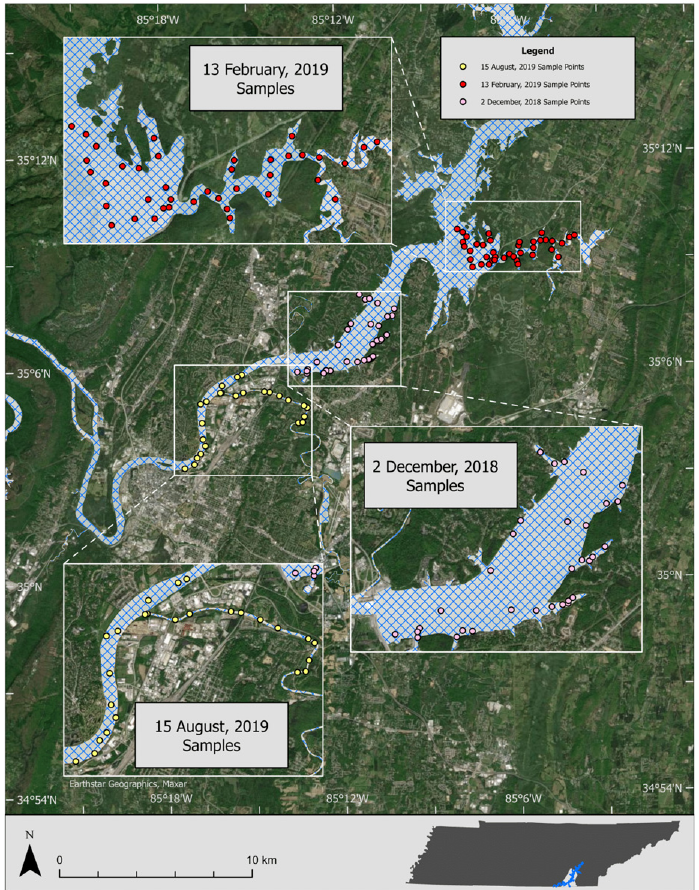
Figure 4. Location of in situ turbidity samples collected on each of the three dates for which Landsat 8 satellite images were